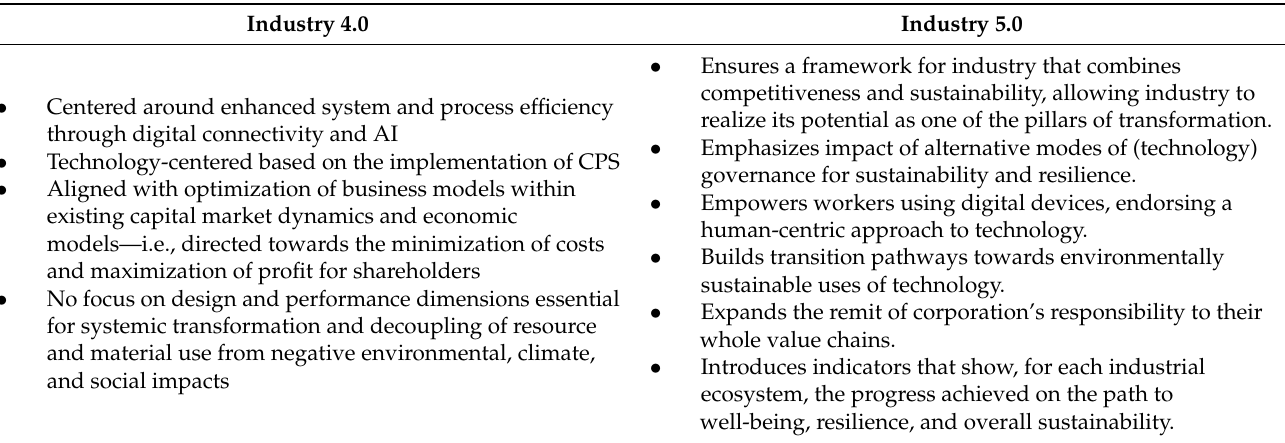
Table 6. Comparison of Industry 4.0 versus Industry 5.0 [69].